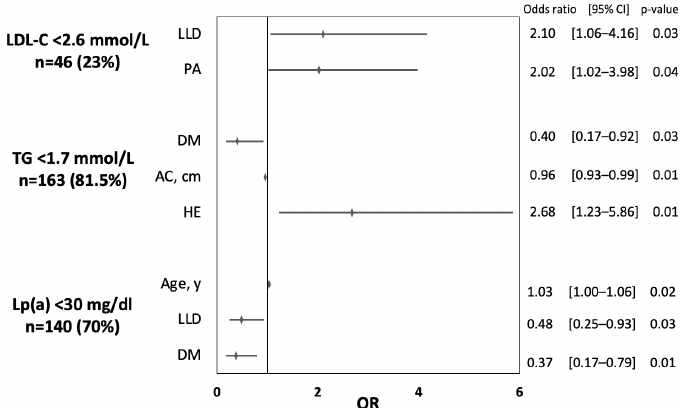
Figure 2. Determinants of adequate control of lipid parameter based on the results of multivariate analyses. Rates of patients with adequately controlled lipid parameters are reported in round brack- ets. (LLD—lipid-lowering drugs; PA—physical activity; DM—diabetes mellitus; AC—abdominal circumference; HE—higher education.)